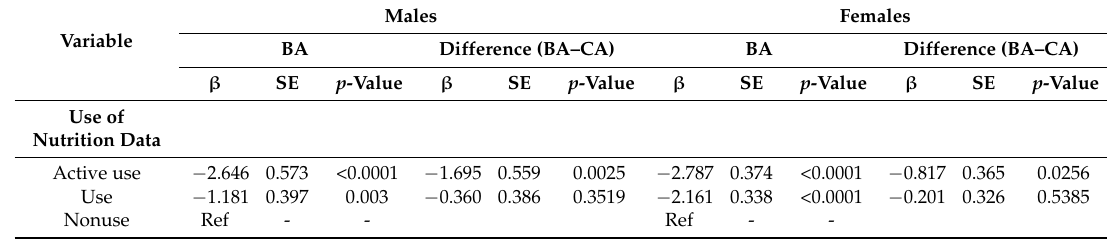
Table 3. Results of linear regression analyses of the association between the use of nutrition data and BA or